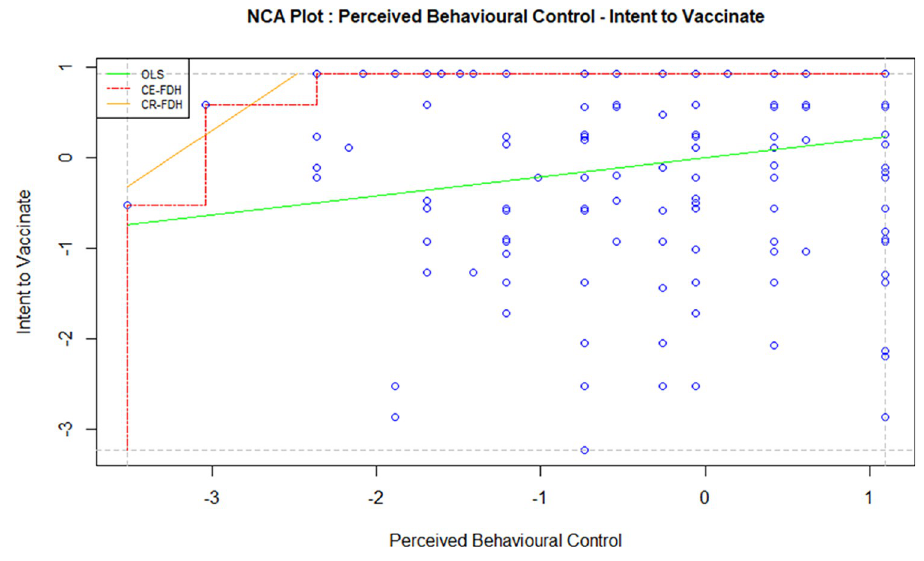
Fig 5. NCA (perceived behavioural